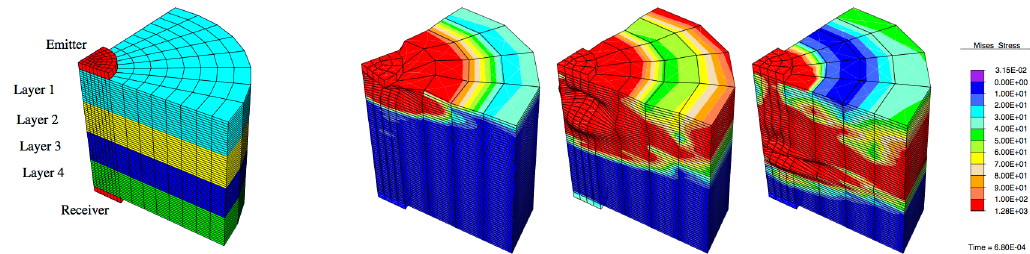
Figure 1. Left: geometry, layers, transducers and mesh. Following pictures: three instants of torsional propagation t = 280, 460 and 680 µ s, using a simpler mesh.